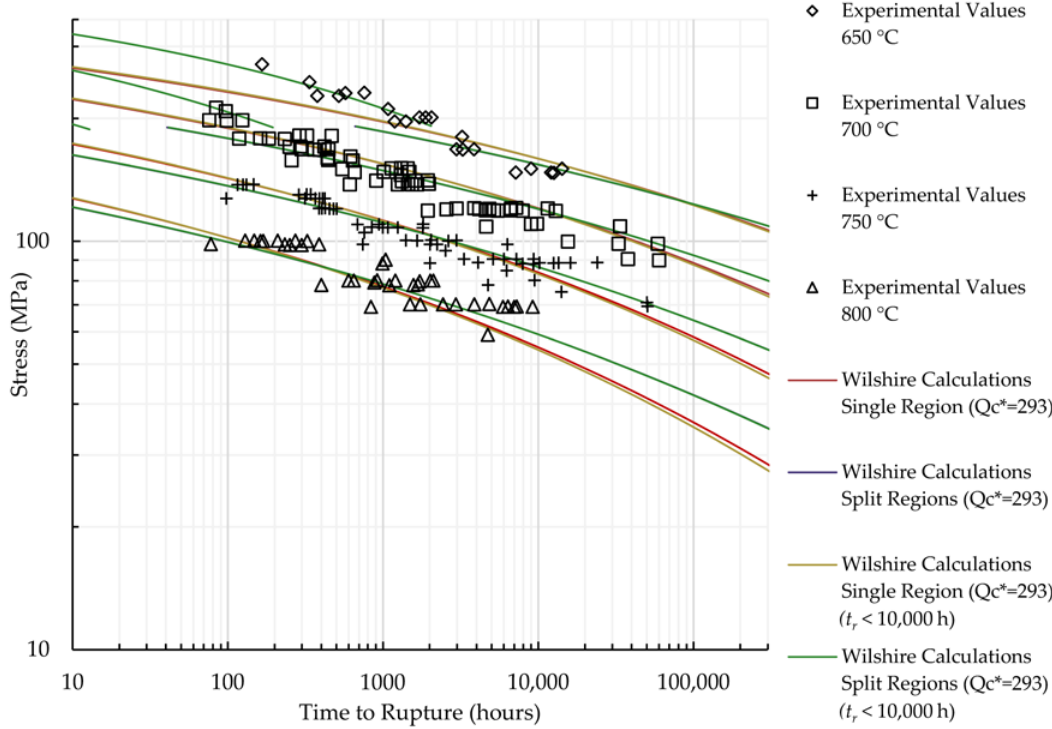
Figure A9. Calculations of the Wilshire equation for HR6W with the self-diffusion activation energy of austenitic stainless steels as Q ∗